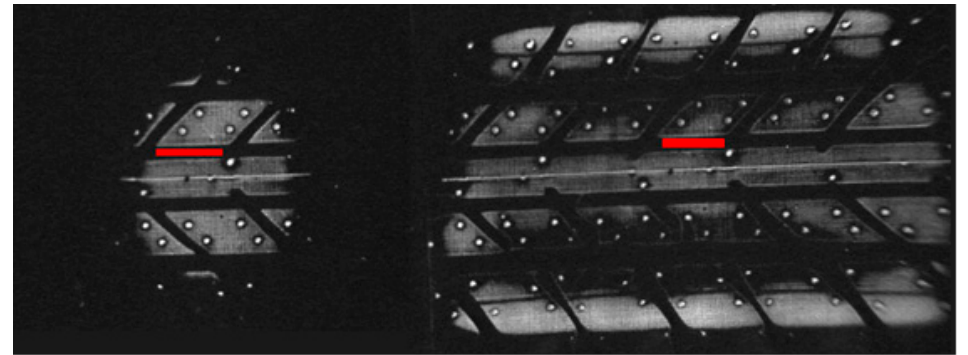
Figure 7. Diffuse light: unloaded tire ( right ); and loaded tire ( left ).